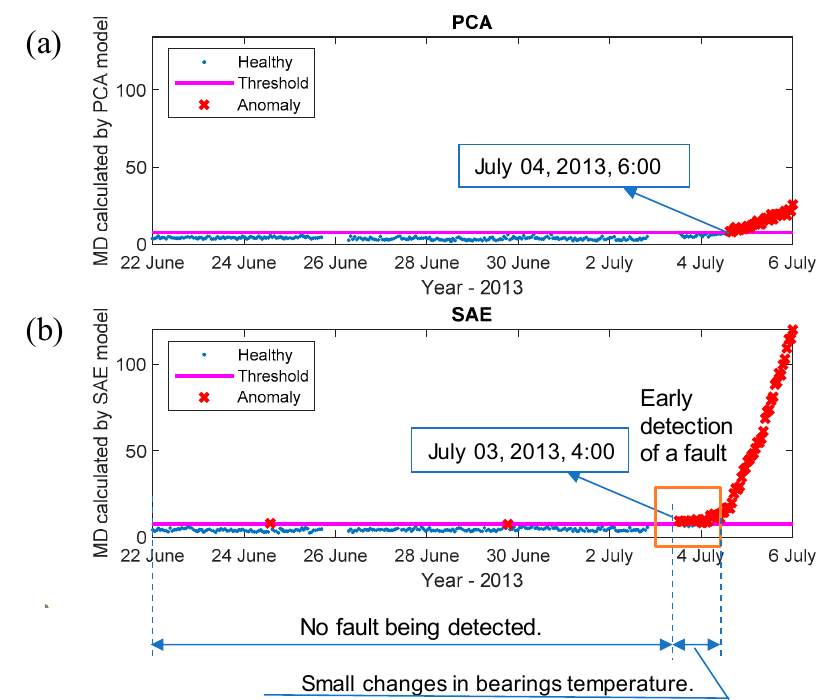
Figure 5. Anomaly detection from 22 June 2013 to 6 July 2013. ( a ) Anomaly detection by PCA. ( b ) Anomaly detection by SAE.